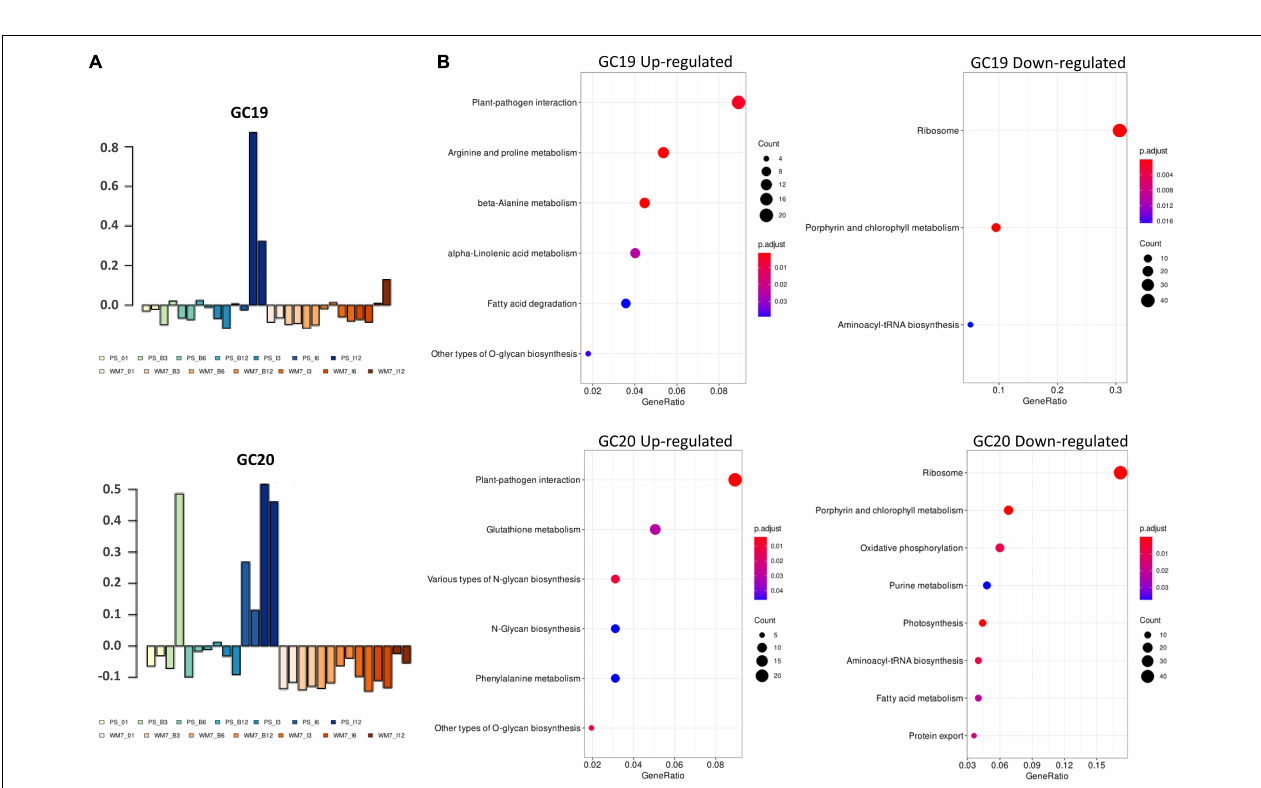
FIGURE 2 | Module eigengenes across samples for the gene clusters GC19 and GC20 (A) . KEGG enrichment profile of up- and down-represented genes within each cluster (B) . I: ToLCNDV inoculated; B: mock inoculated; 01: 0 dpi, 3: 3 dpi, 6: 6 dpi, 12: 12 dpi.